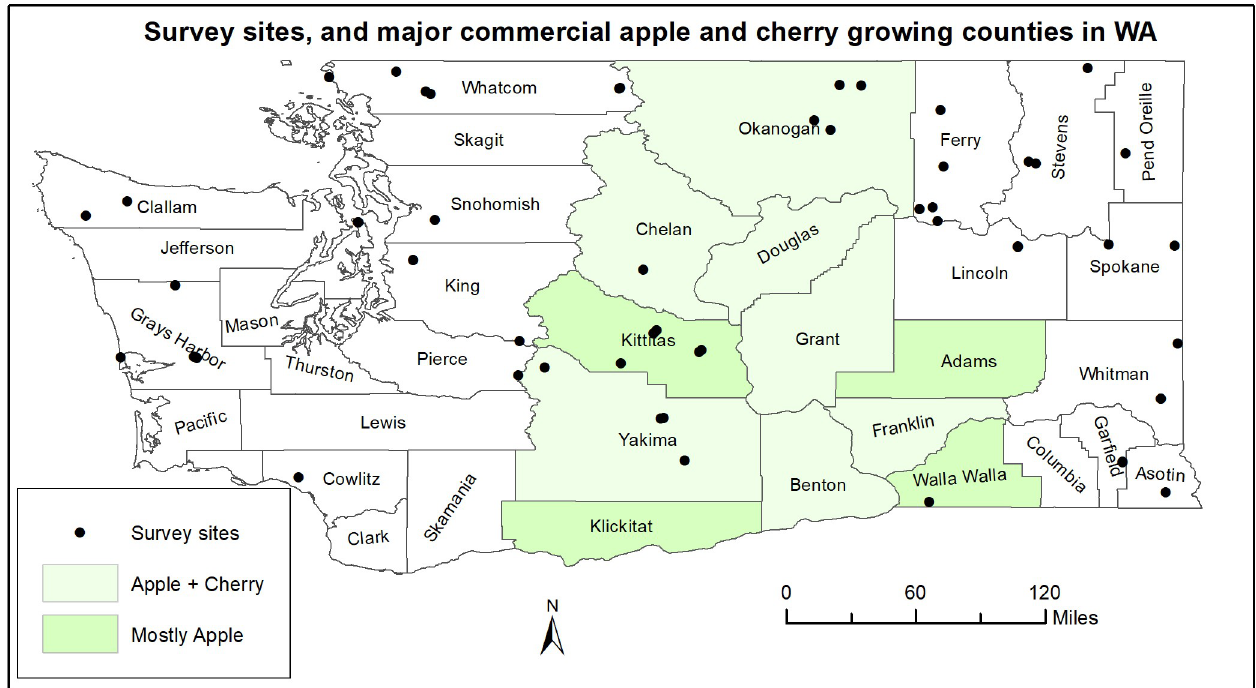
Fig 1. Survey sites, and major apple and cherry growing counties. Fly and host plant abundance data were collected from 61 randomly generated sites (shown in black dots) in 2015 and 2016. Major commercial apple growing regions in WA include all the major commercial cherry growing counties, and Kittitas, Adams, Klickitat and Walla Walla Counties. Major commercial cherry growing counties in WA are Yakima (28%), Chelan (18%), Benton (15%), Grant (12%), Douglas (10%), Franklin (~9%), and Okanagan (~9%). Data source: WA Apple Commission.